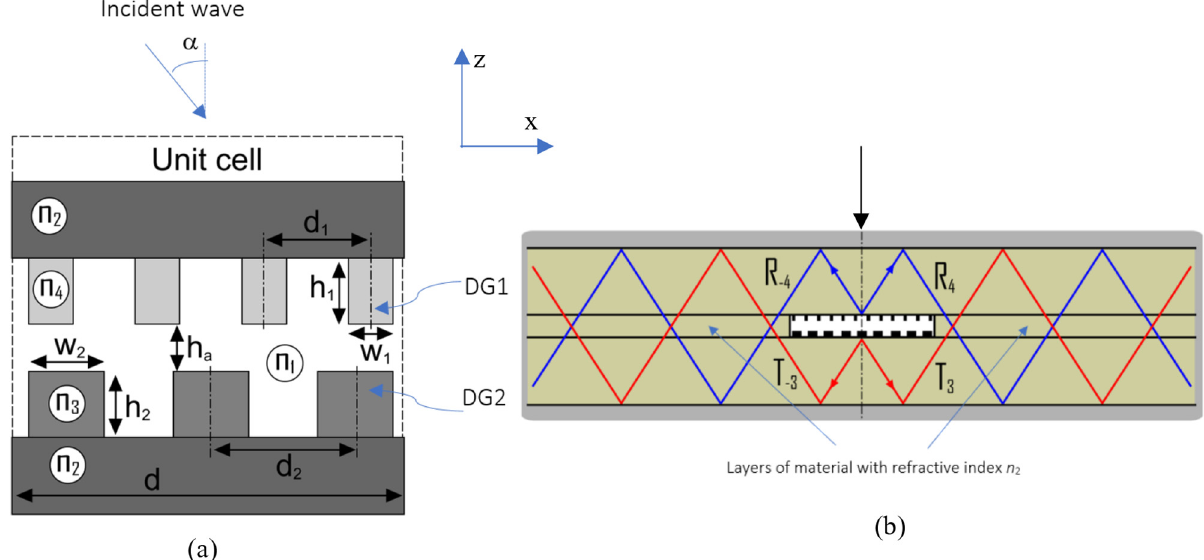
Fig. 4. (a) Cross-sectional view of the unit cell of metagrating; (b) geometry and distribution of diffraction order propagation. In this example use of a metagrating, the fourth re fl ected order R ±4 ( M R *=4) and third transmitted order T ±3 ( M T *=3) will be in-coupled into the